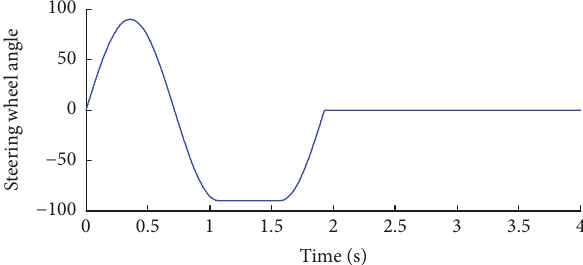
Figure 4: Steering wheelanglewith 89 km/hSindwell at90 ∘ steering